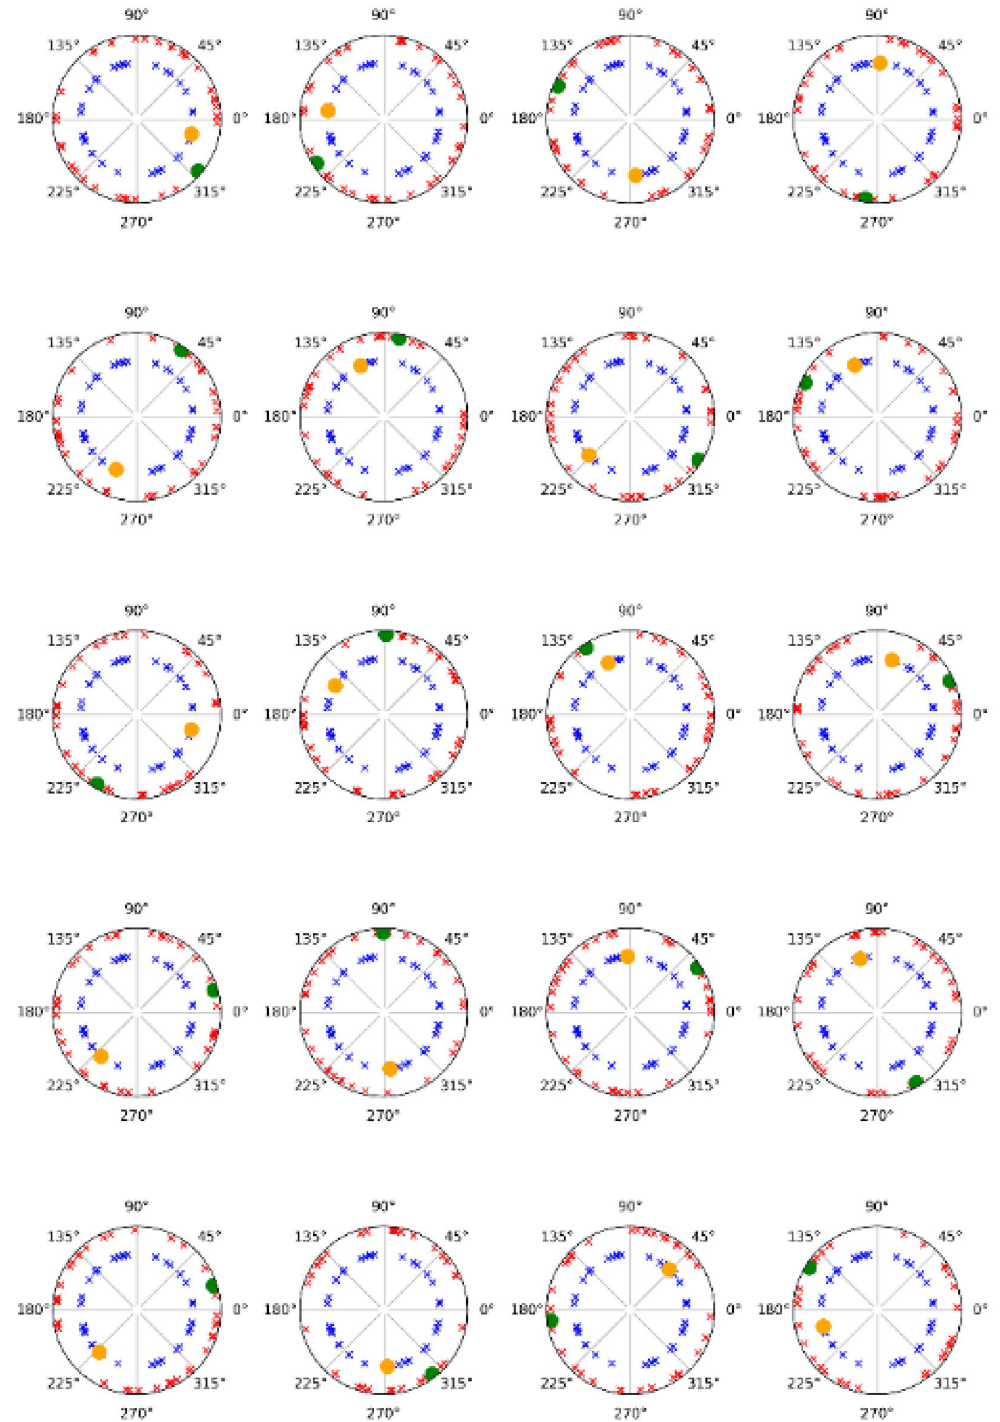
Figure 6. Phase values of the alpha band. The phase-locked values of the alpha band for phase-locked and nonphase-locked activities following the presentation of the target (20 subjects). The green dots and red crosses represent phase-locked and nonphase-locked activity (respectively) when the target is displayed in the left visual field. Yellow dots and blue crosses are when the target was displayed in the right visual field. The individual representations demonstrate that nonphase-locked values are randomly distributed in all subjects and are not centered around the values of phase-locked